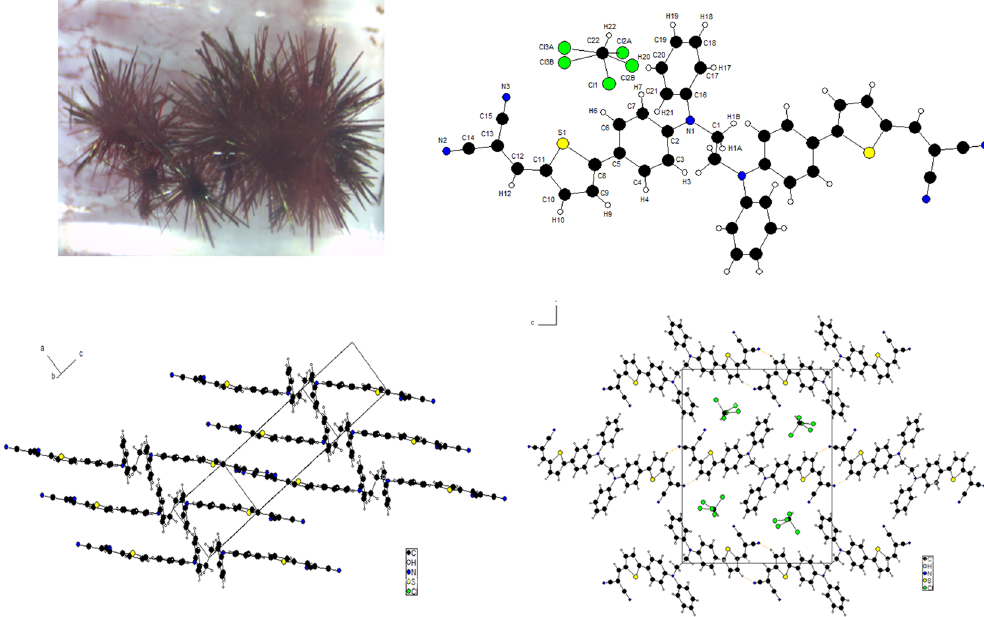
Figure 7. Top: Crystal (left) and molecular crystal structure of D (right). Bottom π - π stacking (left) and hydrogen bonding